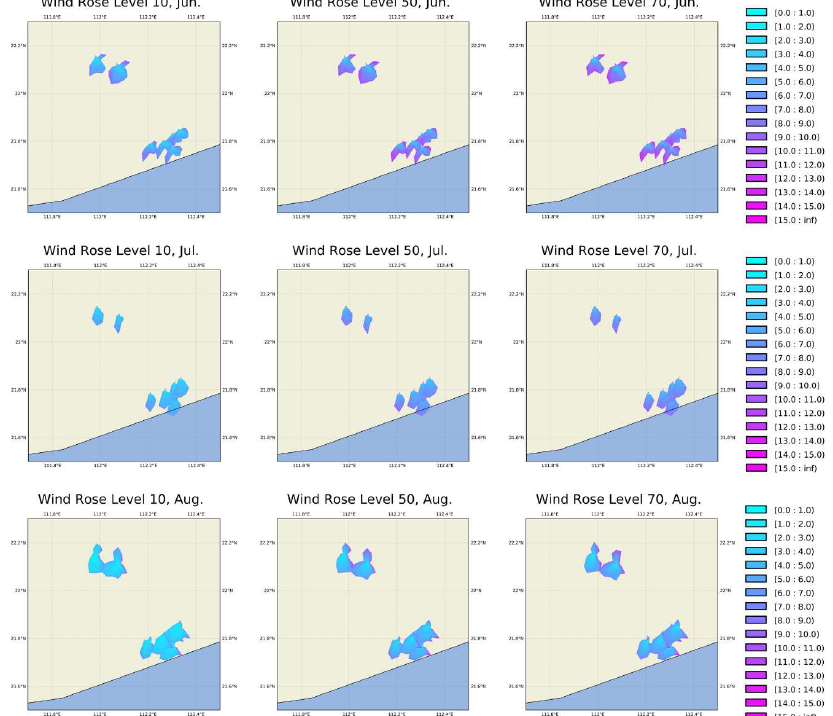
Figure A2. Wind rose of Test 2 results in the seven tower positions in summer (Jun., Jul., and Aug.).